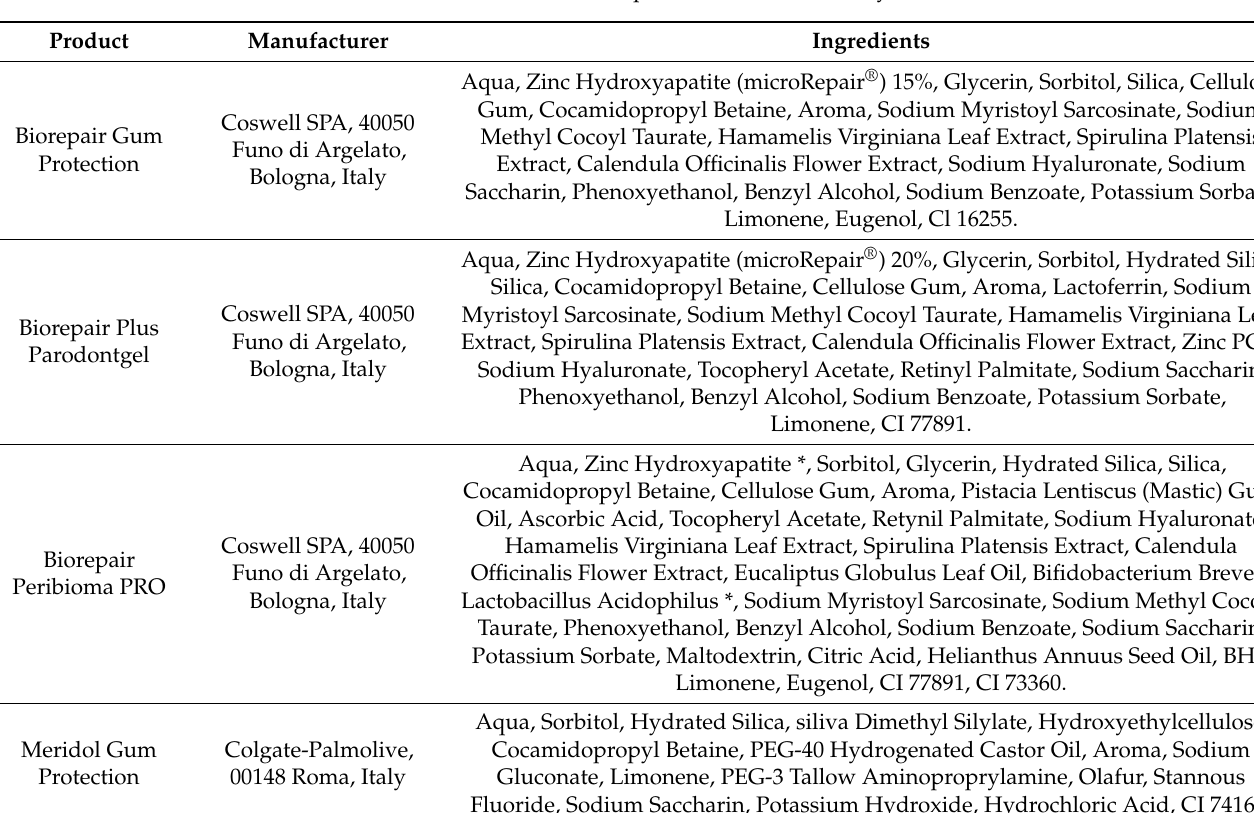
Table 1. List of the toothpastes tested in this